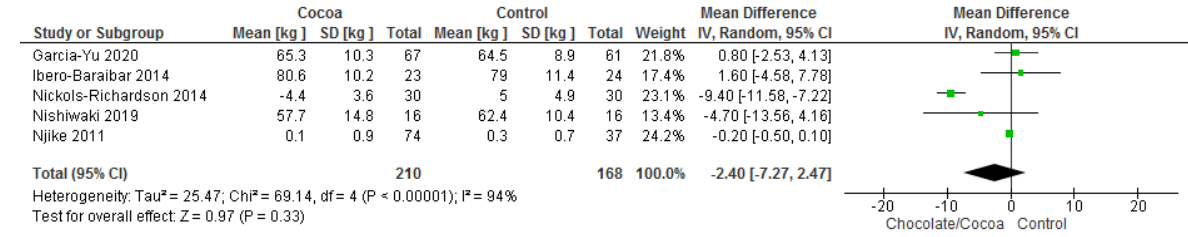
Figure 9. Forest plot of comparison: chocolate versus control, with the outcome - body weight (kg). Nichols-Richardson (2014) and Nijike (2011) reported mean changes and their respective SD, instead of mean scores.